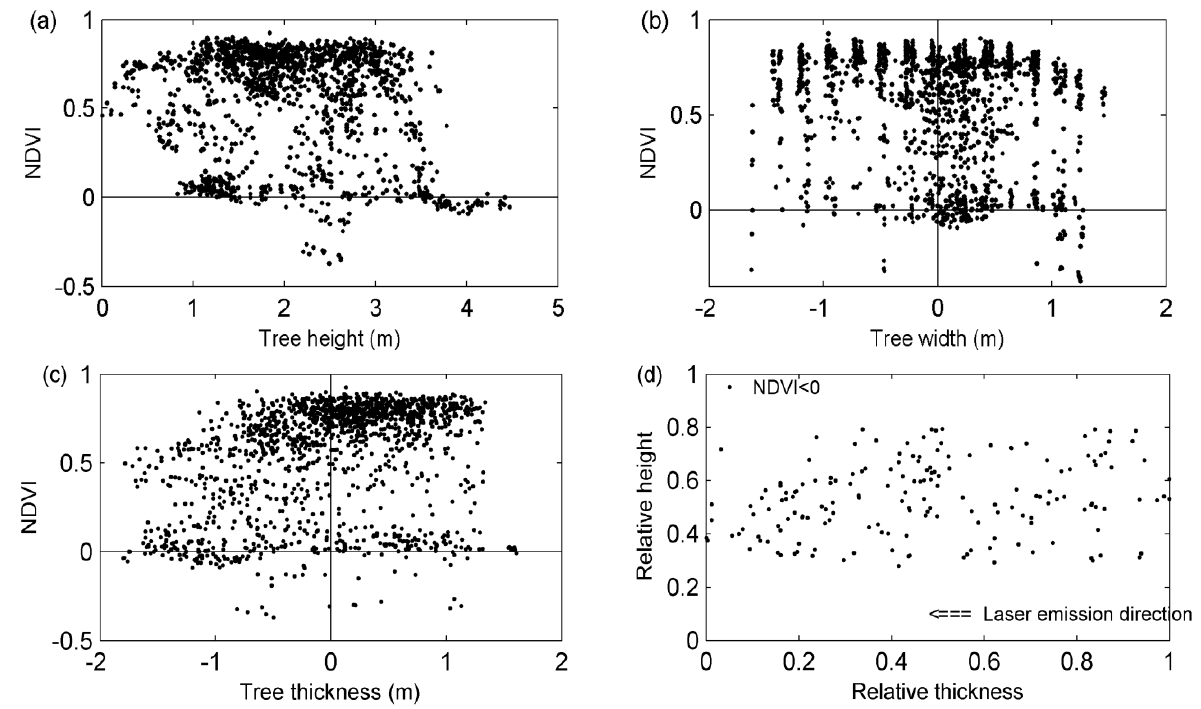
Figure 6. Illustration of the NDVI values along with tree height ( a ), tree width ( b ), and tree thickness ( c ) for a PO tree. ( d ) shows the relative spatial distribution of all of the points with NDVI < 0 lying in the scanned half-crowns for the 18 PO